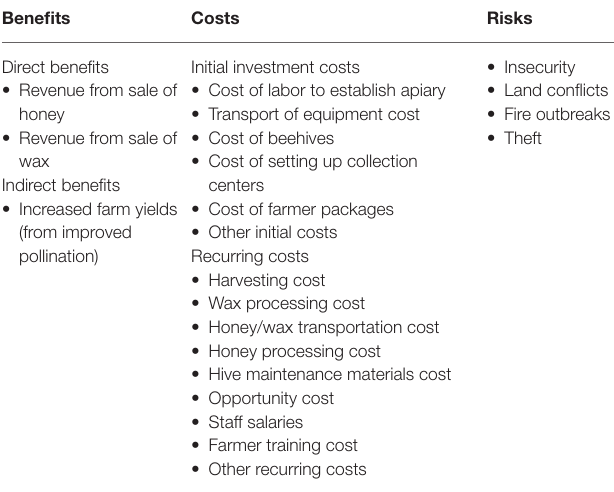
TABLE 2 | List of variables used to populate the beekeeping